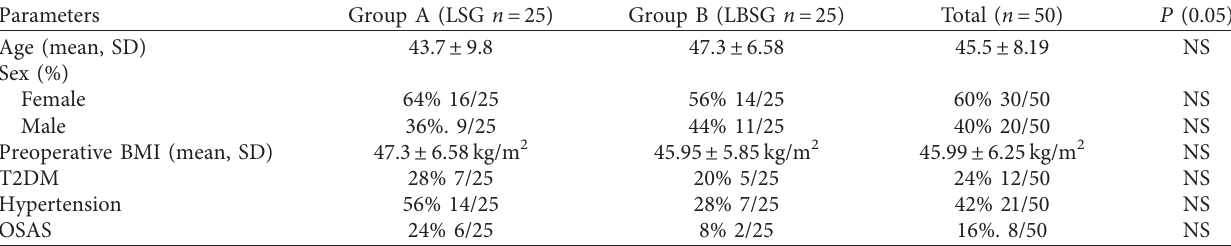
Table 1: Preoperative data.